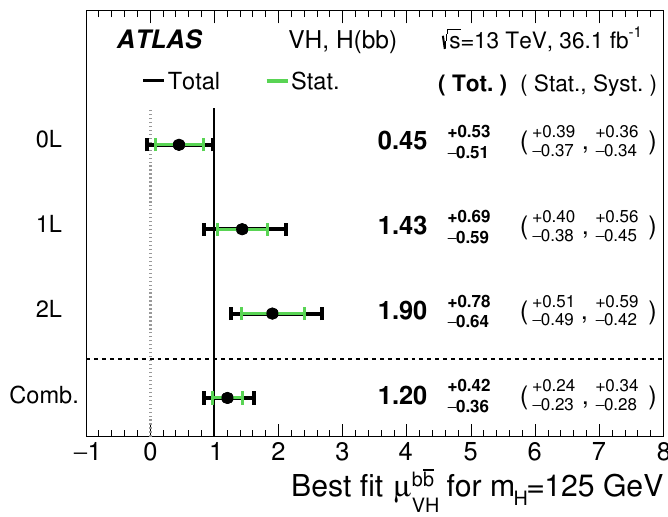
Figure 4 . The (cid:12)tted values of the Higgs boson signal strength parameter (cid:22) for m H = 125 GeV for the 0-, 1- and 2-lepton channels and their combination. The individual (cid:22) values for the lepton channels are obtained from a simultaneous (cid:12)t with the signal strength parameter for each of the lepton channels (cid:13)oating independently. The compatibility of the individual signal strengths is 10%.